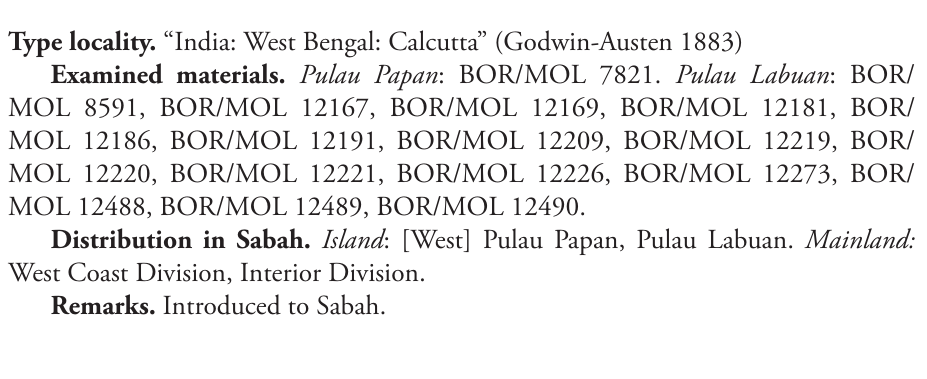
Type locality. “Malaysia: Sabah: Lahad Datu–Tabin Valley” (Vermeulen et al. 2015) Examined materials. Pulau Tiga : BOR/MOL 1100. Pulau Manukan :